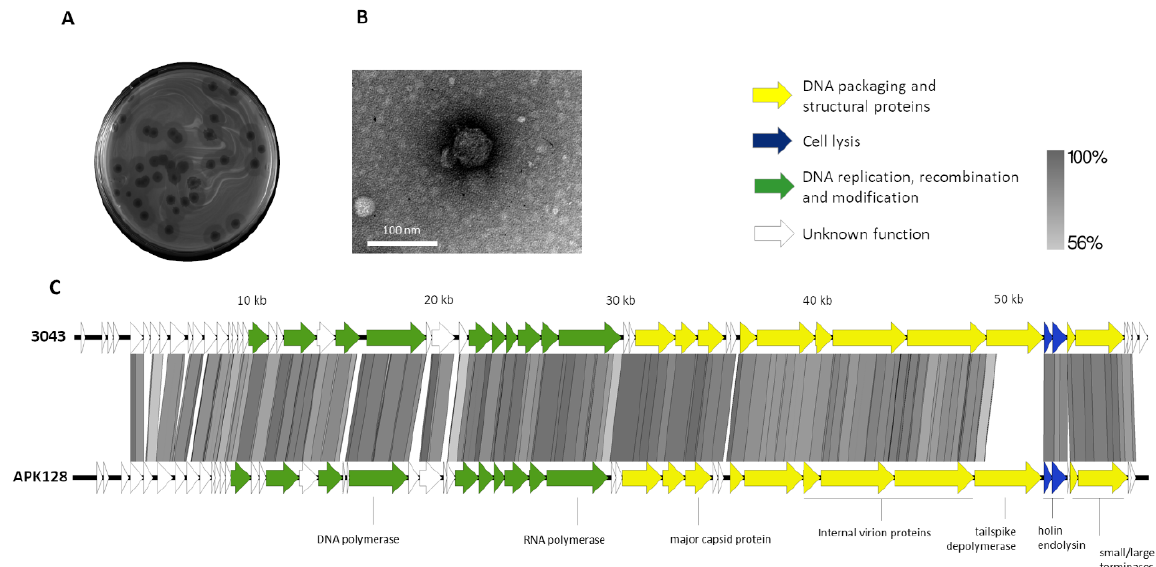
Figure 1. Morphological and genomic analysis of phage 3043-K38. ( A ) morphological images of the phage plaque and ( B ) TEM micrographs (scale bar, 100 nm) negatively stained with 2% uranyl acetate. ( C ) Genomic map of phage 3043-K38 (53 predicted proteins are coloured according to their function) compared with Acinetobacter phage APK128 using the Easyfig [12] program and TBLASTX comparisons.